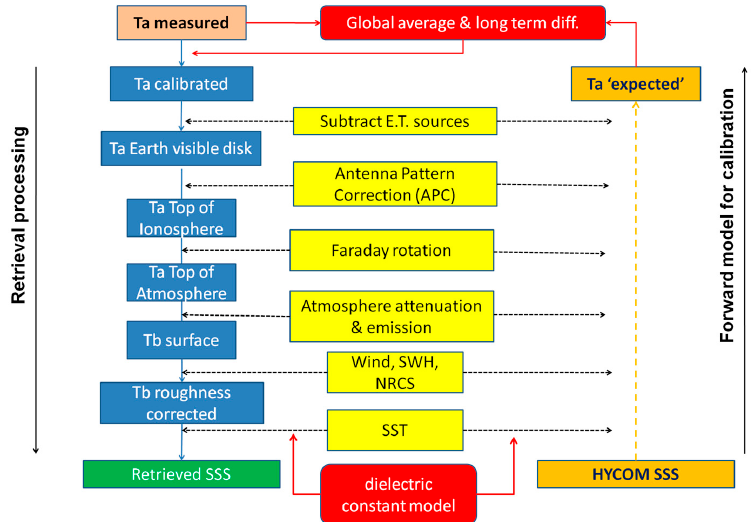
Figure 3. Schematic of Aquarius empirical calibration and SSS retrieval algorithm. The first step (top left) is to calibrate the antenna temperatures (TA) measured by the sensor using the forward radiative transfer model that will also be used in the retrieval to compute expected TA (right hand side of the diagram). This step assumes a reference SSS (e.g., from a numerical model) and uses the same ancillary data (e.g., sea surface temperature, wind, atmospheric parameters, . . . ) that are used in the retrieval step. Global averages over seven ‐ day periods for TA are used in the calibration to mitigate the impact of uncertainty in the reference SSS and other errors. The retrieval steps are illustrated on the left side, starting with TA calibrated at the top, going down the chain to remove unwanted contributions and ultimately retrieve TB at the ocean surface corrected for surface roughness. The last step is retrieving the SSS from the roughness ‐ corrected TB. Other SSS product algorithm will differ slightly. More details are given in Section 2.3.